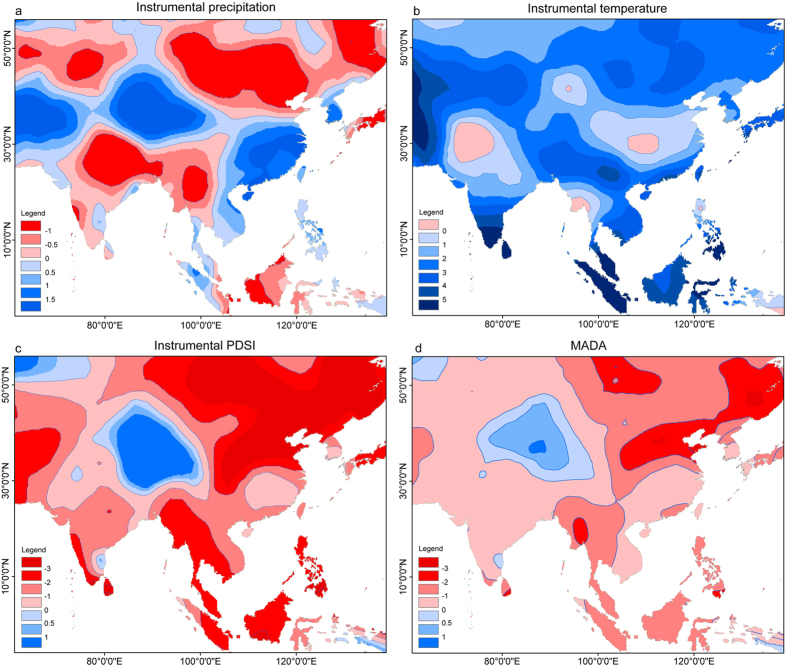
Trends of (a) the instrumental precipitation, (b) the temperature and (c) the Palmer drought severity index (PDSI) from 1951 to 2009 calculated using the Mann-Kendal method, as well as (d) the ratio between mean PDSI from 1981 to 2005 and the reconstructed PDSI from 1300 to 2005 in the monsoonal Asian drought atlas (MADA). The positive values indicate an increasing trend and vice versa. The figure was generated by the software of ArcMap 10.2 and Adobe Illustrator.